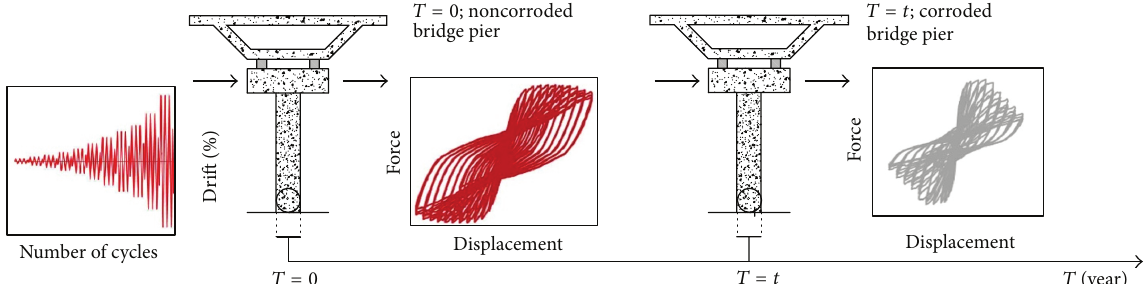
Figure 3: Force-displacement response of a corroded bridge pier over